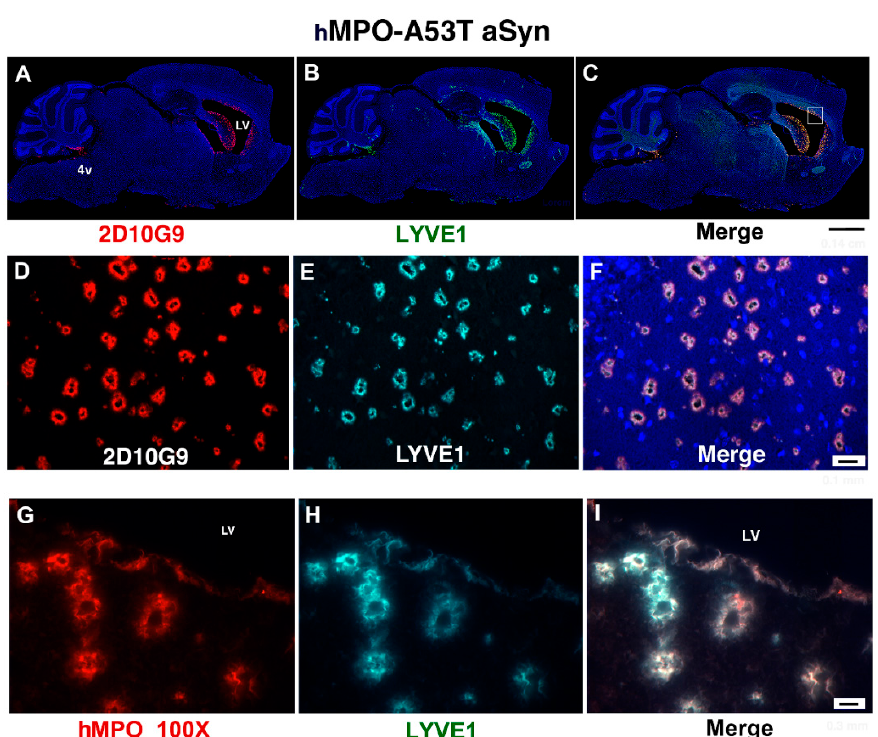
Figure 2. Antibodies to hMPO, 2D10G9 (detects HOCl modified epitopes), and LYVE1 (glymphatic vessel marker) colocalize in dystrophic vessels bordering the lateral ventricles in the hMPO-A53T mouse brain. ( A – C ) Immunofluorescence staining of a whole mount sagittal section of hMPO-A53T mouse brain shows colocalization of 2D10G9 (( A ), Alexafluor 594, red) and LYVE1 (( B ), Alexafluor 488, green) and the merged image in Panel ( C ). Immunofluorescence is visible in vessels around the lateral ventricles (LV), and 4th ventricle under the cerebellum. The box ( C ) shows an example of location of vessels as seen in ( D – F ). Scale bar: ( A – C ) 1.5 mm. ( D – F ) Higher magnification (20 × ) of these regions shows the vessels around the ventricle stained for 2D10G9 (( D ), Alexafluor 594, red) and LYVE1 glymphatic/lymphatic vessel marker (( E ), Alexafluor 488, green) and the merged image ( F ). Scale bar: ( D – F ) 0.1 mm. ( G – I ) Higher magnification of panels of ( D – F ) (100 × , oil immersion) shows the atypical structure of the vessels which have lumens surrounded by walls of filamentous and granular components. Some vessels appear to open to the lateral ventricle (LV). Scale bar: ( G – I ) 0.03